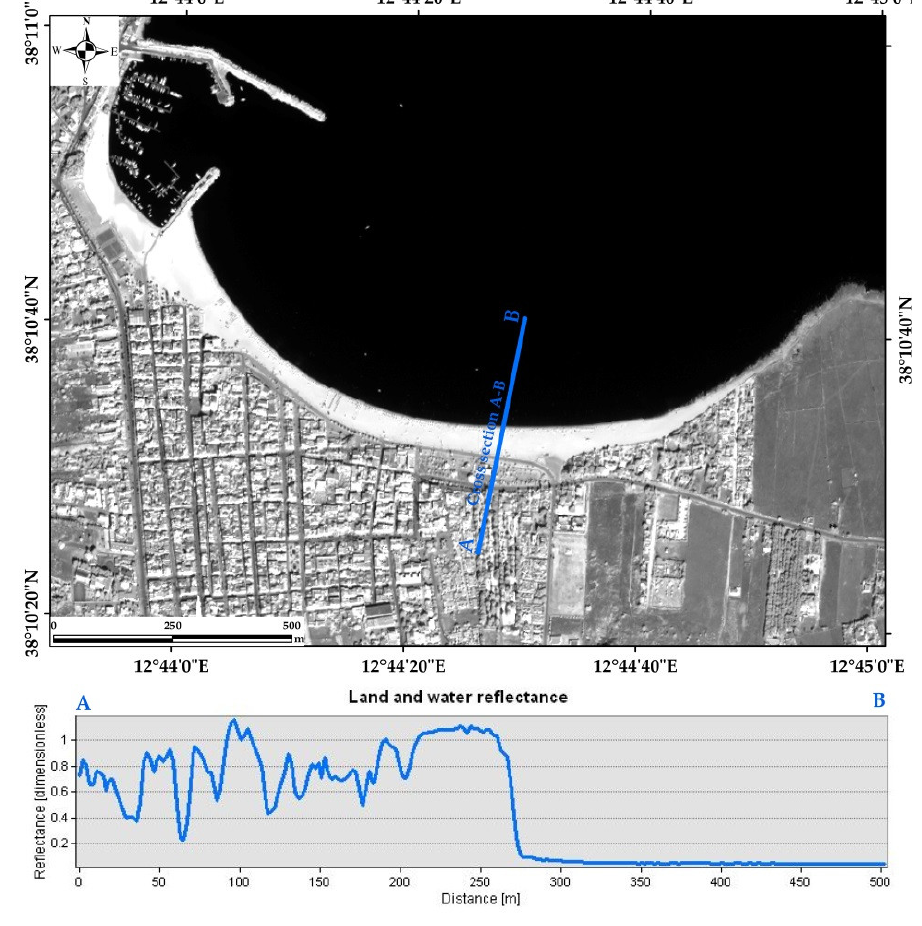
Figure 3. Reflectance thresholding on GeoEye-1 NIR band. The blue line indicates the interpolated line (cross-section A-B) used for land and water reflectance extraction. The blue profile graph indicates the variation of reflectance with low and constant values extracted on water and high and fluctuating values extracted on non-water pixels.